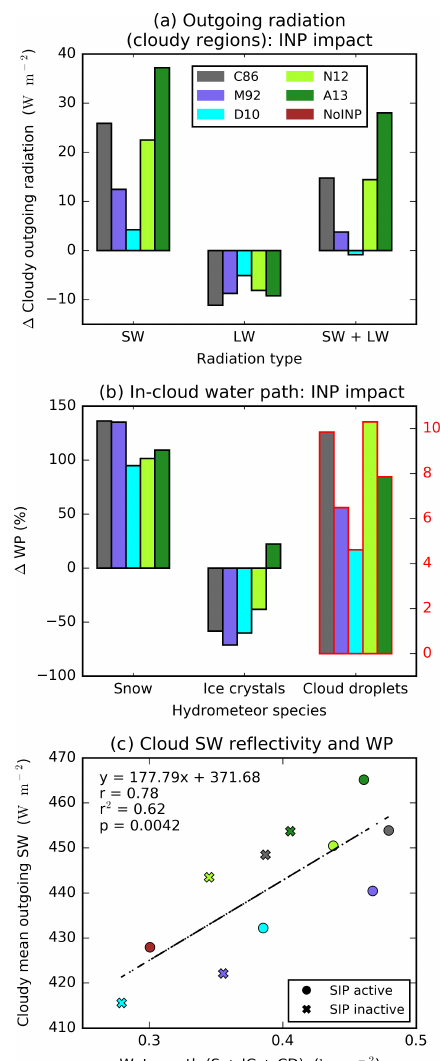
Figure 5. INPs and TOA outgoing daytime (10:00–17:00UTC) ra- diation from cloudy regions. Absolute change in outgoing short- wave, longwave and total radiation from cloudy regions relative to the NoINP simulation (i.e. (cid:49) Rad cl used in Eq. 1) (a) ; the percent- age change in water path (WP) associated with snow (S), ice crystals (IC) and cloud droplets (CD) relative to the NoINP simulation (b) ; and mean daytime outgoing shortwave radiation from cloudy re- gions plotted against the sum of S, IC and CD water paths (c) . Note the different scale for CD water path in panel (b) . In addition to the simulated values, a regression line ( n = 11) is shown in panel (c) along with its associated statistical